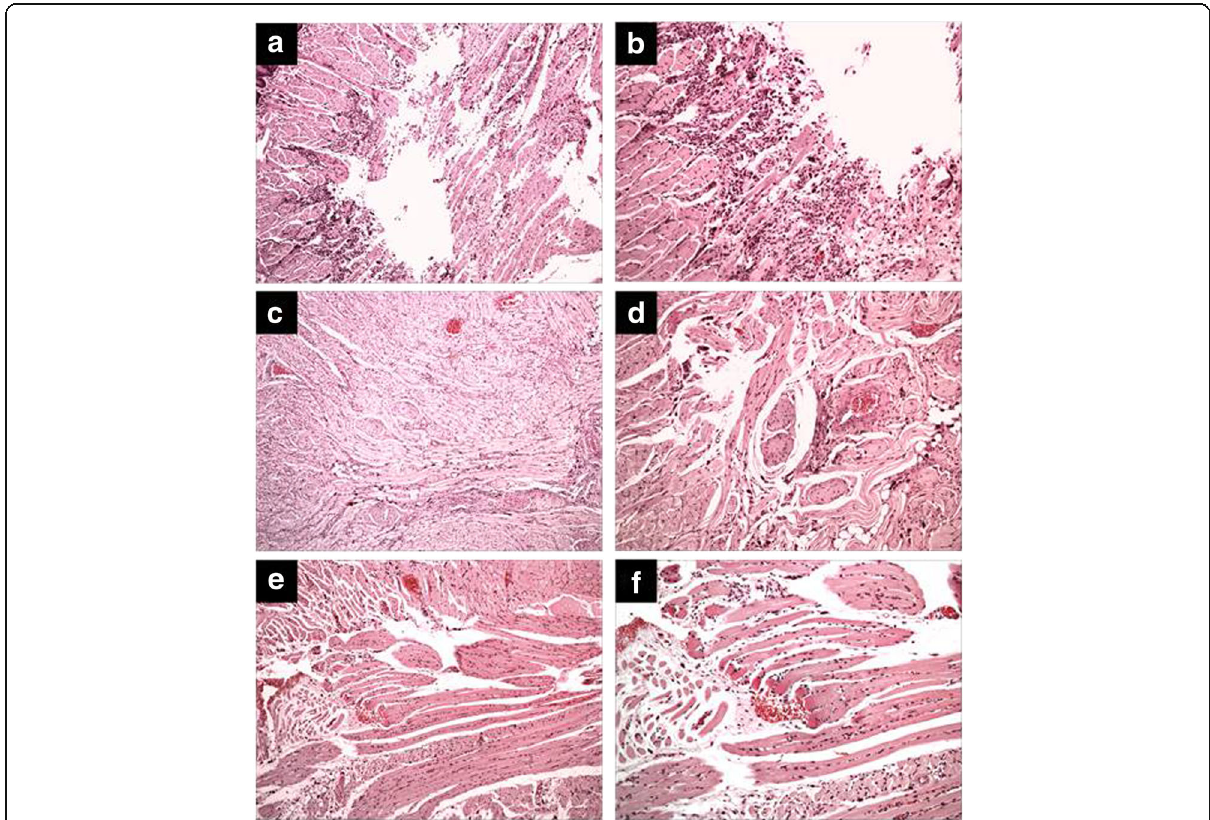
Fig. 2 Effect of treatment with copaiba oil-resin on transfixing lesions in rats ’ tongues stained by hematoxylin and eosin (HE). Panels ( a and b ) represent the control group. Panels ( c and d ) represent the dexamethasone group. Panels ( e and f ) represent the copaiba oil-resin group. It is found that the groups dexamethasone and copaiba oil-resin showed similar aspects decreasing chronic inflammatory infiltration and edema, compared to the control